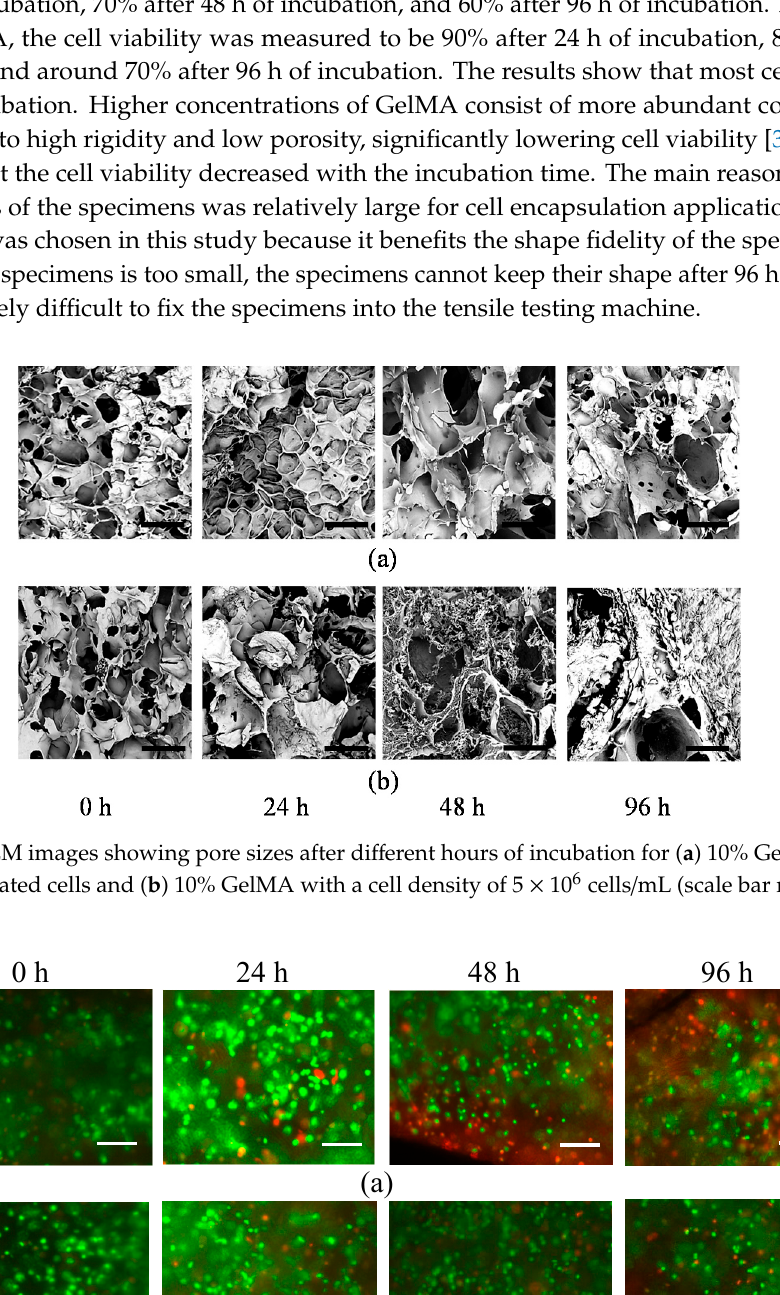
Figure 10. Postfabrication cell viability images after incubation for ( a ) 10% GelMA with 5 × 10 6 cells/mL and ( b ) 5% GelMA with 5 × 10 6 cells/mL (scale bar represents 300 µm).